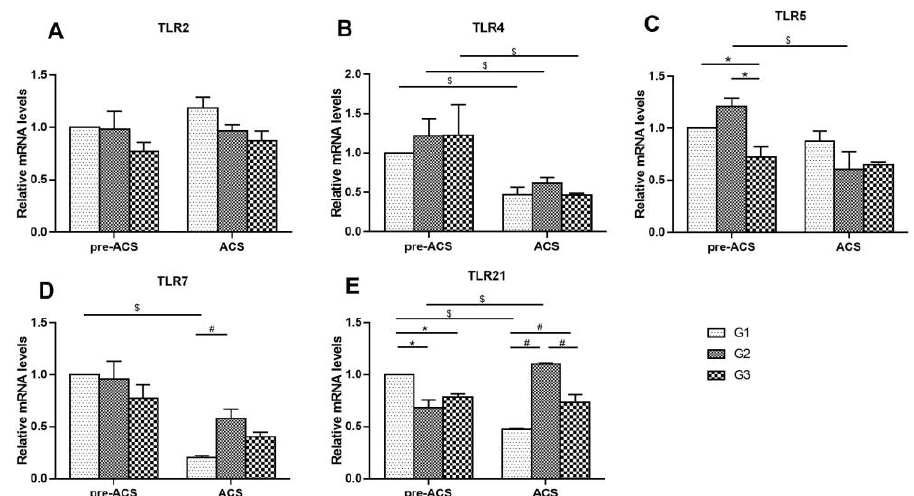
Figure 4. The mRNA levels of Toll-like receptors TLR2 ( A ), TLR4 ( B ), TLR5 ( C ), TLR7 ( D ), and TLR21 ( E ) in ilea of broilers before and after ACS. Data were presented as mean ± SD ( n = 6). Different labels represent significant differences ( p < 0.05). pre-ACS (*), ACS (#) and before and after ACS ($). G1, cold stimulation for 0 h; G2, cold stimulation for 3 h; G3, cold stimulation for 6 h.